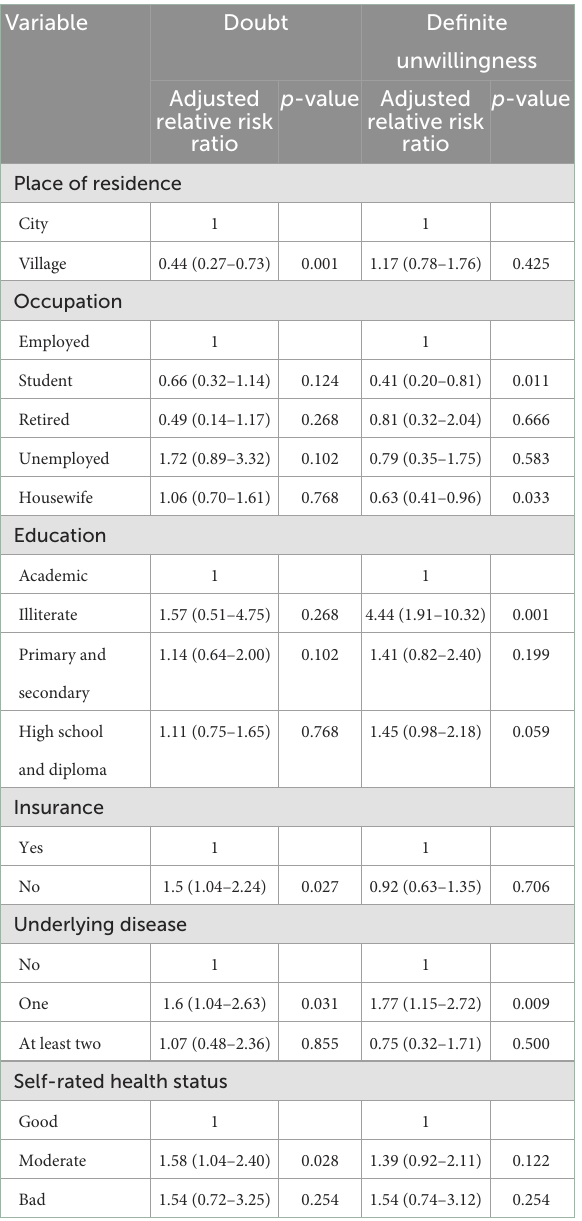
TABLE 4 Multinomial logistic regression of factors affecting doubt and unwillingness to receive the vaccine.